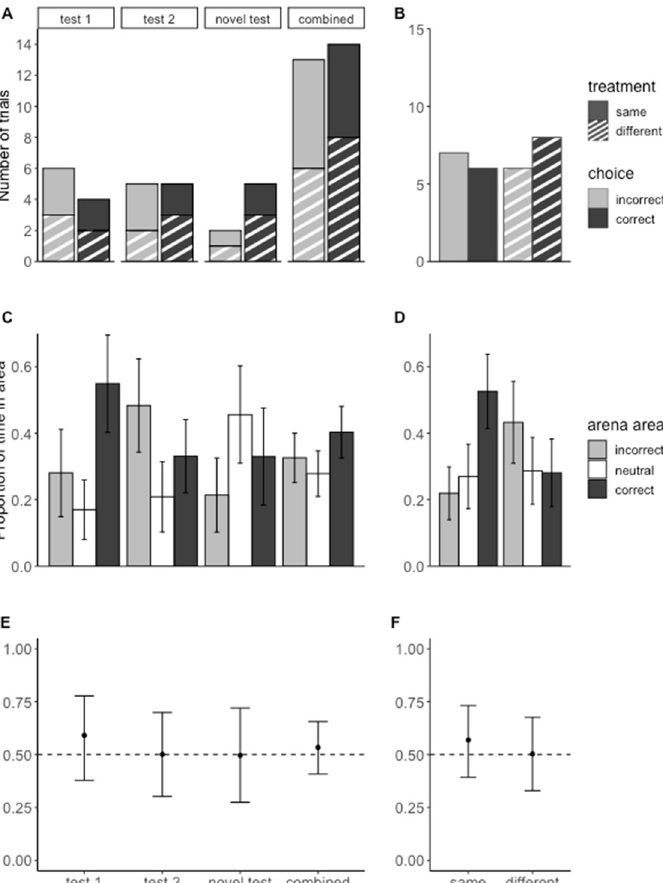
Figure 6. Test trial results from Experiment 2—Cross-modal same/different assay . ( A ) Barplot of initial choice in two-choice tests. The initial choice for trained stimuli tests was not significantly different on test day 1 (X-squared = 0.4, p -value = 0.53), test day 2 (X-squared = 0, p -value = 1), or for the novel stimulus tests on day 3 (X-squared = 1.29, p -value = 0.26). Three trials were dropped from the analysis of the novel test because the amblypygids did not probe either the C+ or C − doors. The ‘combined’ bars are the results from all three days of testing combined. ( B ) Barplot of initial choice in two-choice tests for individuals trained to go to the same stimulus as the initial and those trained to go to the different stimulus combined from all three testing days. The same and different treatment groups’ choices were not statistically different from chance (same: X-squared = 0.08, p -value = 0.78; different: X-squared = 0.29, p -value = 0.59). Two trials were dropped from the ‘same’ group and one from the ‘different’ group because the amblypygids did not probe either door. ( C ) Average proportion of time spent in each area of the arena during test trials for all days of testing and all days combined with standard error bars. ( D ) Average proportion of time spent in each area of the arena during test trials where the individuals were trained to learn ‘same’ and ‘different’ with standard error bars ( E , F ). Modeled estimates and their 95% confidence intervals of the proportion of time spent in front of C+ door (excludes neutral zone). A value of 0.5 represents an equal amount of time spent in front of both doors. Individuals did not spend significantly more time in front of the C+ door, indicating P. laevifrons did not learn the concepts of ‘same’ and ‘different’. The test subjects did not spend more time on the correct side of the arena versus the incorrect side on average (Figure 6C,D) (Figure 6E,F; test 1 mean = 0.59, 95% CI = (0.38, 0.78); test 2 mean = 0.51, 95% CI = (0.30, 0.70)); novel test mean = 0.50, 95% CI = (0.27, 0.72); combined mean = 0.53, 95% CI = (0.41, 0.66); same mean = 0.57, 95% CI = (0.39, 0.73); different mean = 0.50, 95% CI = (0.33,